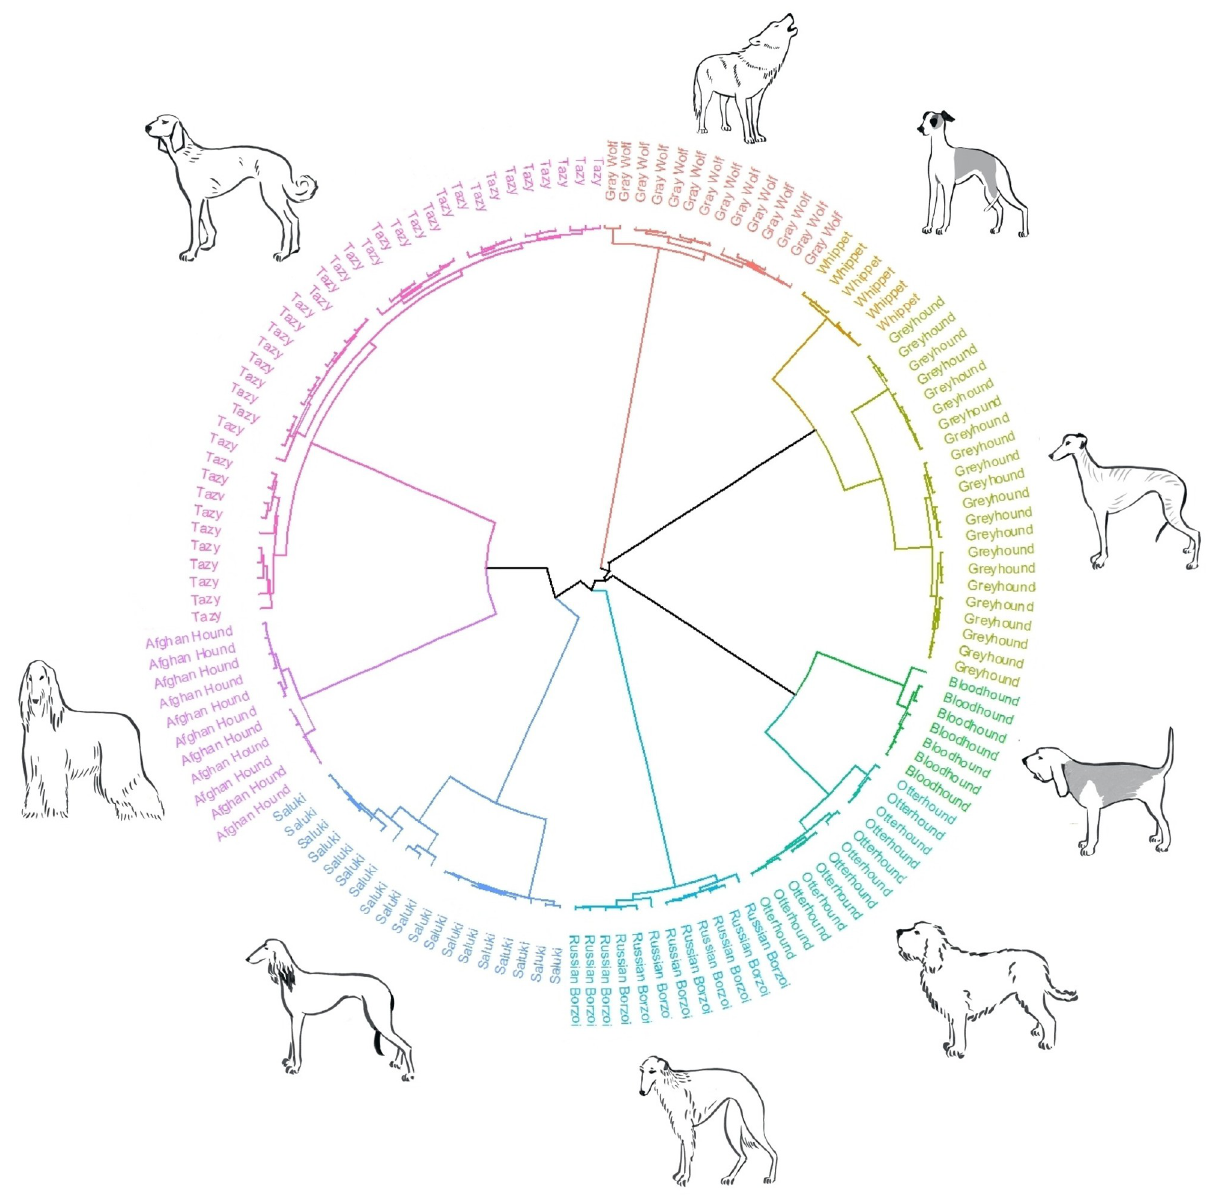
Fig 6. Phylogenetic dendrogram based on SNP markers for breed relationship definition. Phylogenetic network constructed using complete linkage hieratical clustering based on 40,229 autosomal SNPs for 39 Tazy dogs, 89 dogs from seven sighthound breeds and 14 Grey Wolves. Breeding lines labels were color-coded. Canine images not drawn to scale. Reprinted from https://drive.google.com/drive/folders/1hFzoHRWnQ7-eNeKDZKwBy_ nLaUs3bTJY?usp=share_link] under a CC BY license, with permission from Anna Molodykh, original copyright